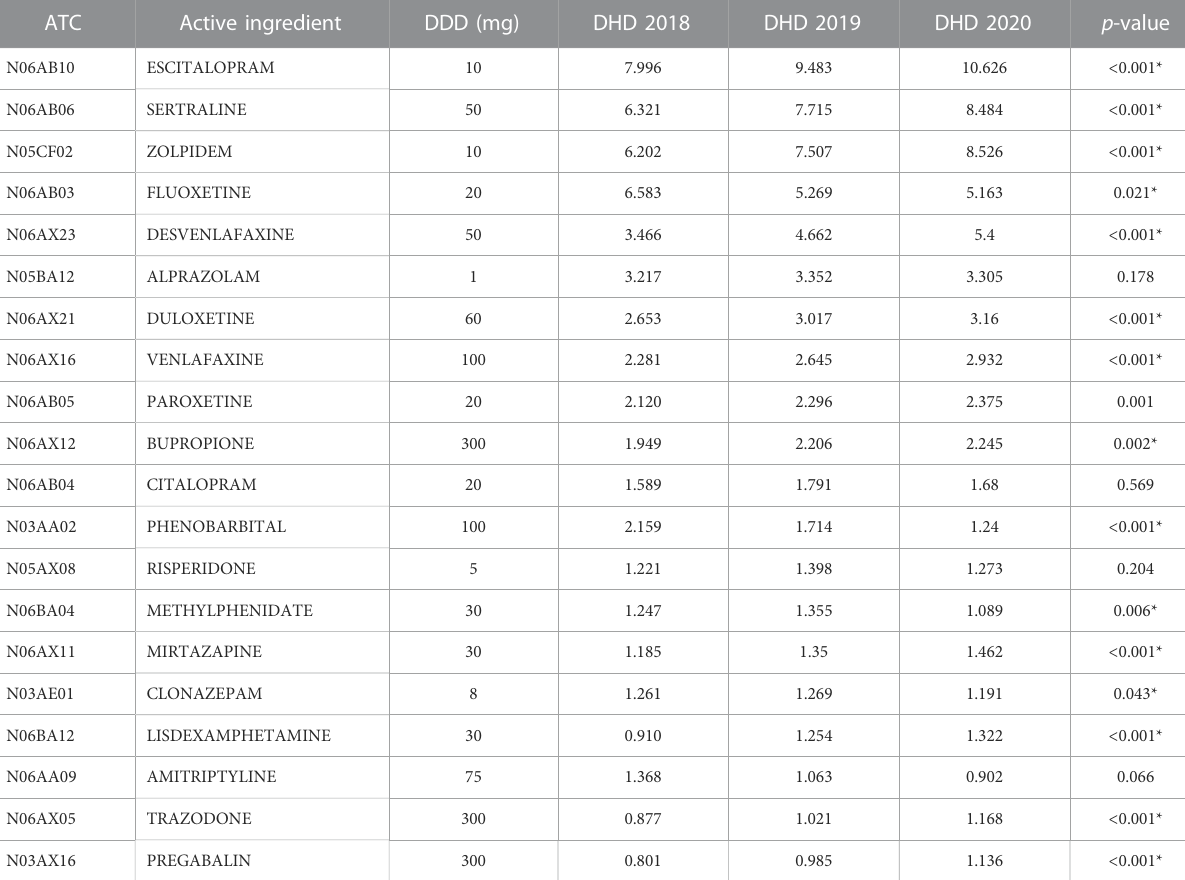
TABLE 1 List and evolution of the 20 psychotropic medications with the highest DHD, base year 2019, registered in the National System for the Management of Controlled Products (SNGPC) database in the Federal District, Brazil, 2018 – 2020. ATC Active ingredient DDD